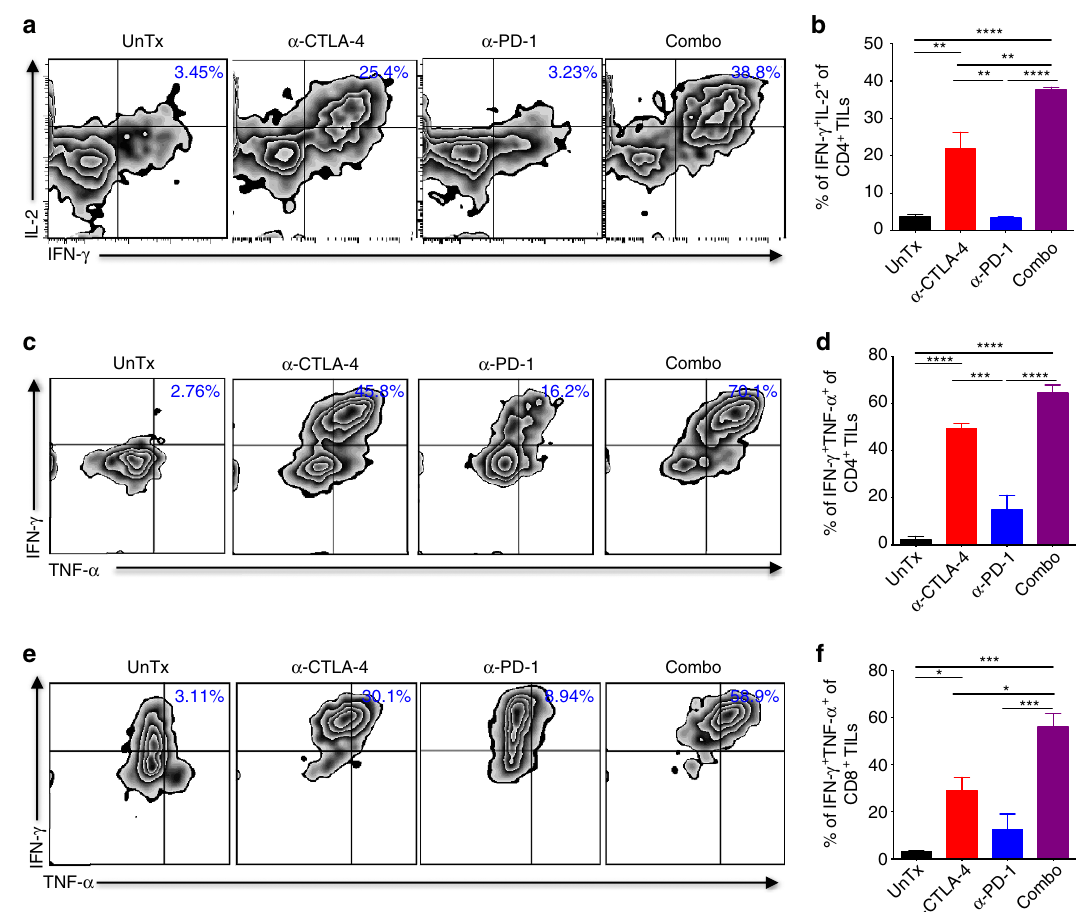
Figure 4 | Combination therapy enhances polyfunctionality of CD4 þ and CD8 þ TILs. ( a ) Purified CD4 þ from TILs described as in Fig. 3 co-cultured with irradiated MB49 cells and splenic DCs in vitro were analyzed to determine the percentages of cells positive for IL-2 and IFN- g . ( b ) Summarized results of dual IFN- g þ IL-2 þ producers from five mice. ( c – f ) Isolated TILs without further purification were stimulated briefly with PMA and ionomycin in vitro , and then analyzed for IFN- g and TNF- a production in CD4 þ TILs ( c ) or in CD8 þ TILs ( e ). Percentages of dual IFN- g þ TNF- a þ producers in CD4 þ or CD8 þ TILs from fiev mice are depicted in ( d ) and ( f ), respectively. Data in the bar graphs are means ± s.e.m. * P o 0.05; ** P o 0.01; *** P o 0.001; **** P o 0.0001 by one-way ANOVA with Bonferroni’s post hoc test. Data are representative of three independent